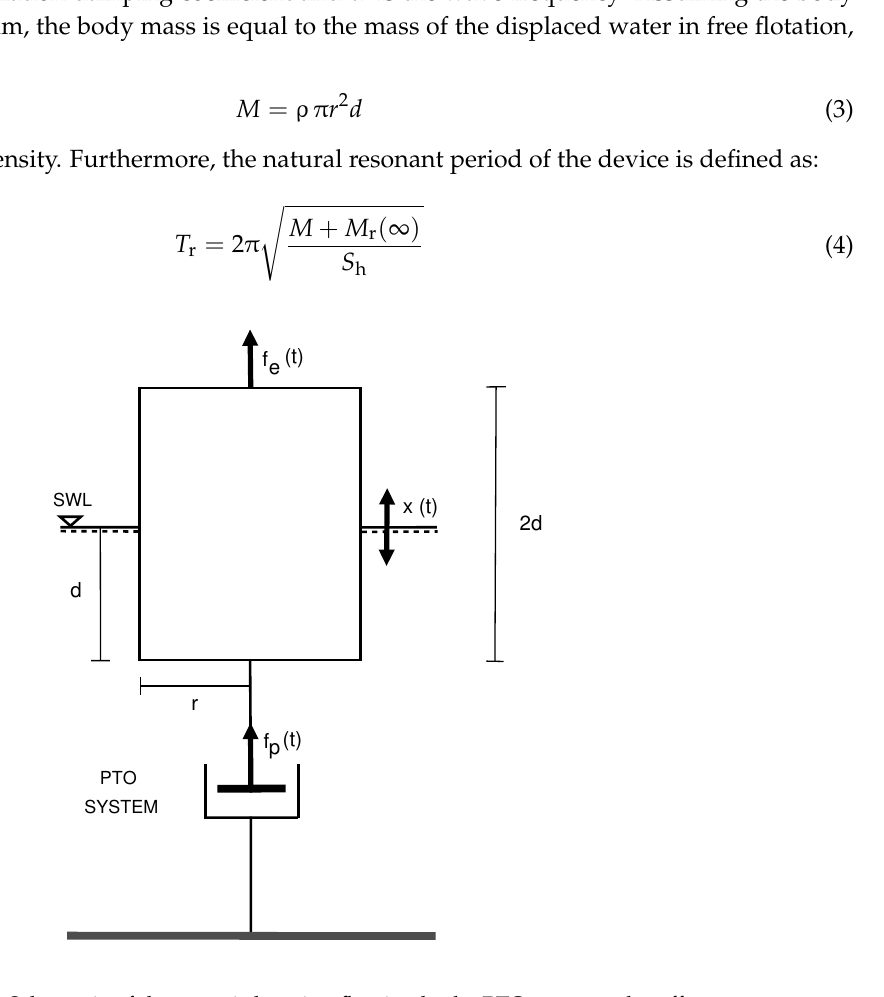
Figure 1. Schematic of the generic heaving floating body. PTO: power